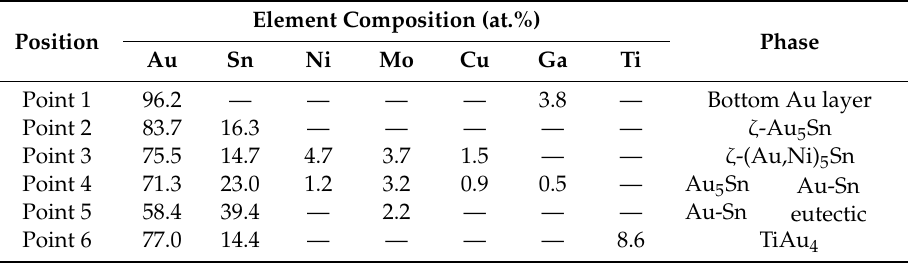
Figure 7. EDS analysis of the Au/Ti/Au|Au-Sn eutectic joint: ( a ) measured position and ( b ) elemental distribution. 3.3. Interfacial Reactions Schematic diagrams of the microstructure evolution in the soldering processes were drawn according to the microstructure and interfacial reactions of the solder joints. Figure 8 shows the schematic diagram of the microstructure evolution of the TiW/Au|Au-Sn joint. The Au-Sn solder started to melt when the reflow temperature reached 280 °C. The terminal metalized 6 µm Au layer on the back of the MMIC partially dissolved into the melting Au-Sn solder, whereas the 3 µm Au layer of the Ni/Au metallization on the Mo/Cu submount completely dissolved into the melting Au-Sn solder. Therefore, the Ni layer was directly exposed to the melting Au-Sn solder (Figure 8b). Consequently, the Au content in the melting solder increased and deviated from the eutectic point, resulting in increase of the liquidus temperature. When the liquidus temperature increased to